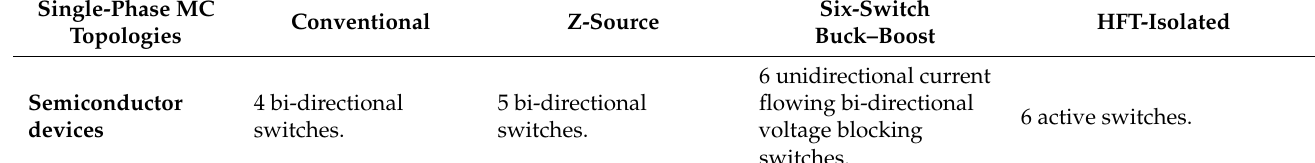
Table 9. Various types of single-phase MC